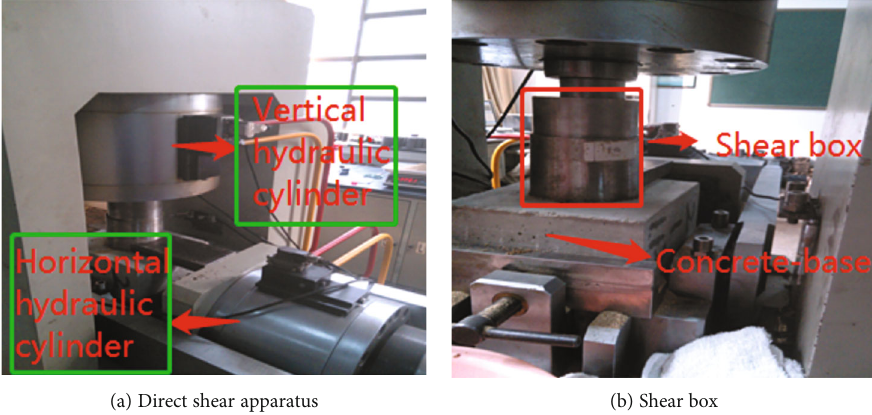
Figure 1: Direct shear apparatus under high